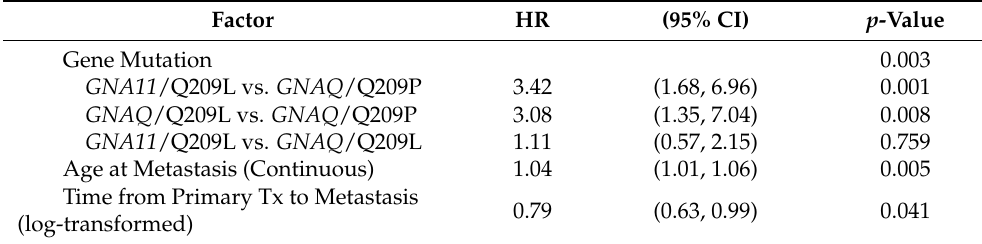
Figure 1. The Kaplan-Meier Curves for Met-to-Death OS. Kaplan-Meier Curves showing patients carrying tumor mutations with Q209L of GNA11 , Q209L of GNAQ and Q209P of GNAQ . The red line represents Q209P of GNAQ ( n = 19), the green line represents Q209L of GNAQ ( n = 14) and the black line represents Q209L mutation of GNA11 ( n = 36). Table 5. Results from the main multivariable Cox Model for OS from Met to